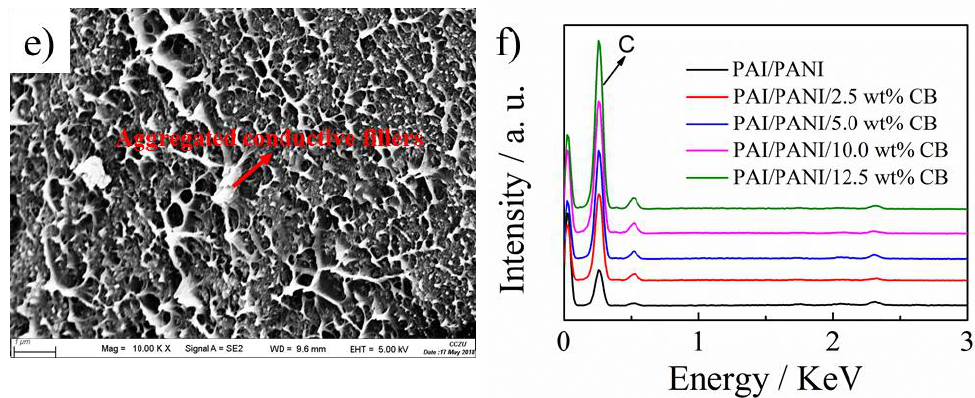
Figure 8. Scanning electron microscopy images of PAI/PANI binary ( a ) and PAI/PANI/ functionalized multi-walled carbon nanotube (FMWCNT) ternary composites with 2.5 wt% ( b ), 5 wt% ( c ), 10 wt% ( d ), and 12.5 wt% ( e ) CB. Energy dispersive X-ray analysis of conductive films ( f ).